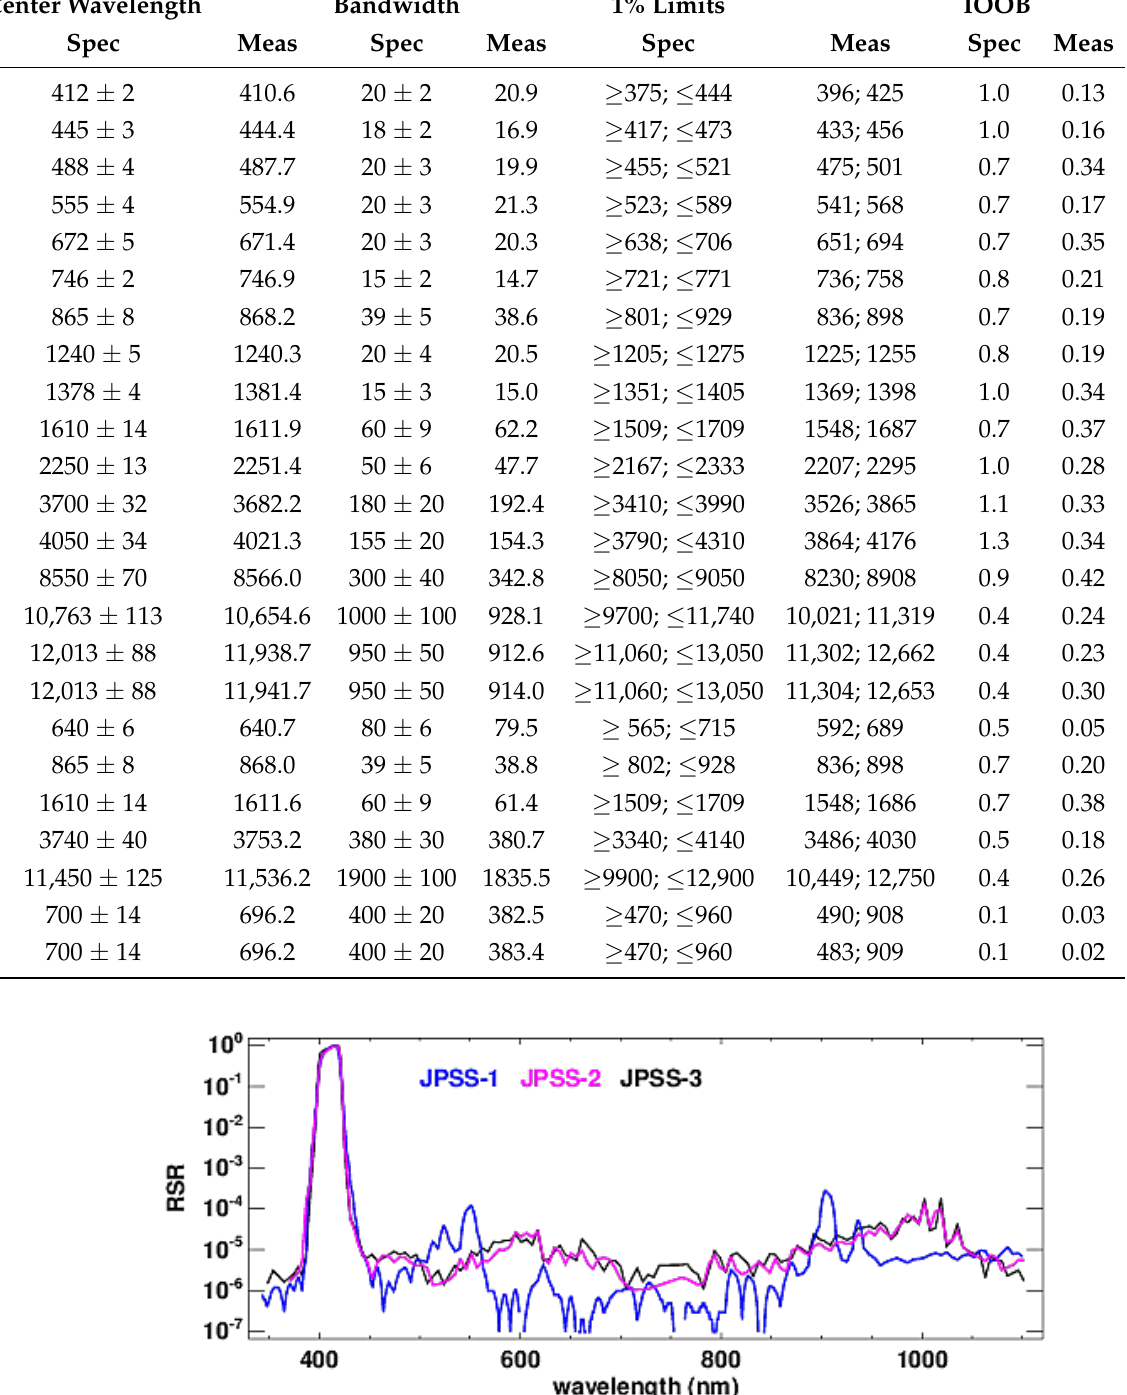
Figure 6. VIIRS M1 out-of-band response comparison between JPSS-1, JPSS-2, and